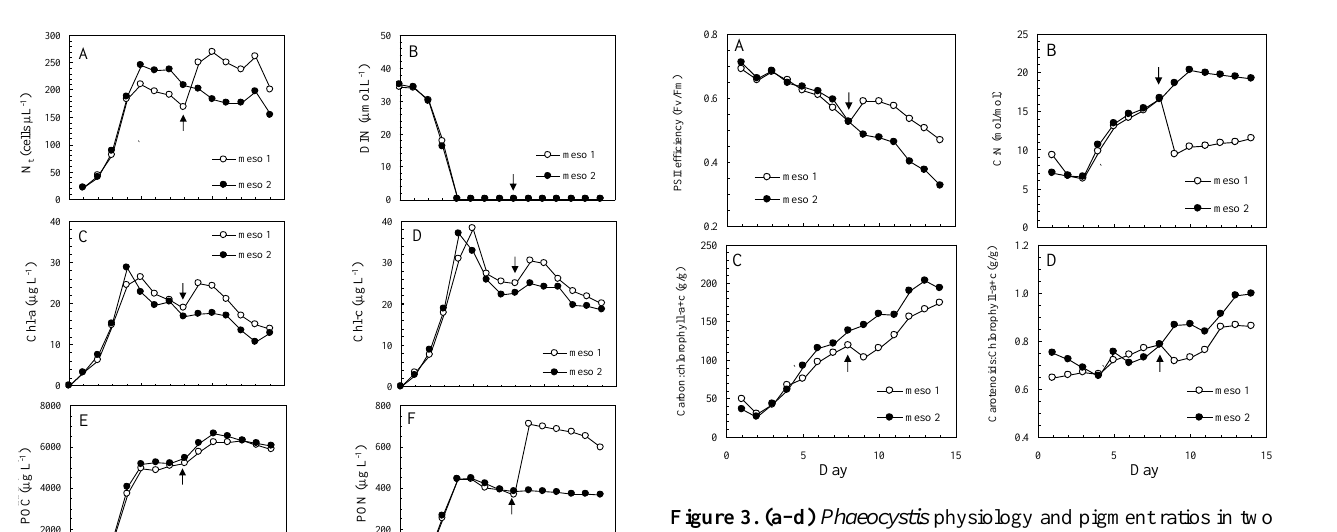
Figure 3. (a–d) Phaeocystis physiology and pigment ratios in two mesocosms in time. (a) Photosystem II efficiency (Fv / Fm), (b) carbon to nitrogen ratio (C:N, molmol − 1 ) , (c) carbon to chloro- phyll a + c ratio (C:Chl a + c , gg − 1 ) , and (d) carotenoids to chlorophyll a + c ratio (gg − 1 ) . The arrow indicates the nutrient ad- dition to mesocosm 1 after sampling on day